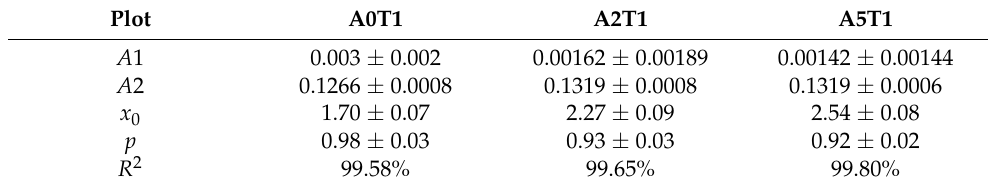
Table 4. Values of the parameters of the logistic curve for each sample (full graphic, Figure 4, 15 days). Plot